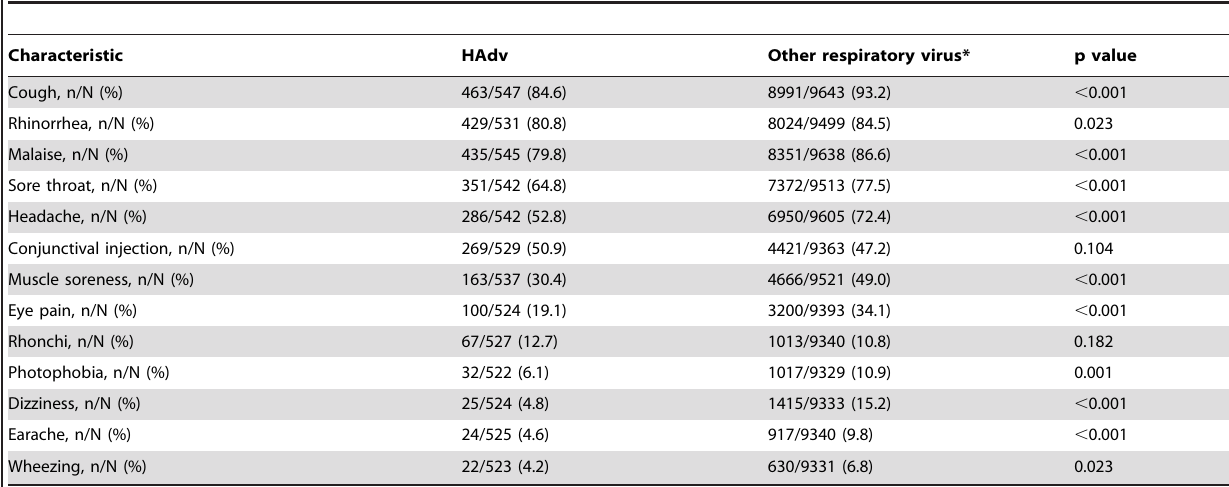
Table 3. Clinical findings of patients with HAdv infection compared with other respiratory virus infections *